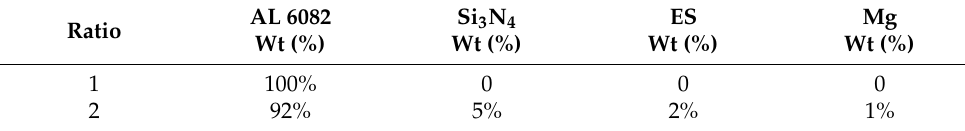
Figure 2. Photograph of; ( a ) crucible casting process ( b ) pouring in pattern, ( c ) cast work piece. Table 2. Mixing ratio of composite.